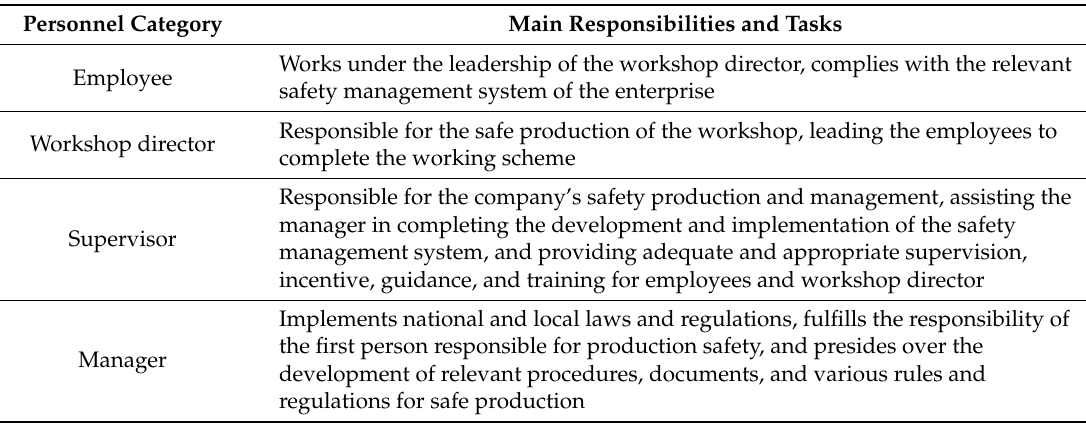
Table 2. The main responsibilities and tasks of each personnel category involved in the